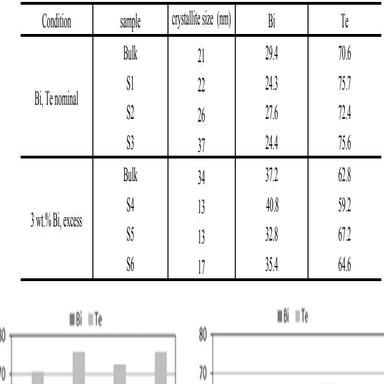
EDX analysis of the Bi2Te3 thin films as-deposited and annealed in vacuum and N2 atmospheres.